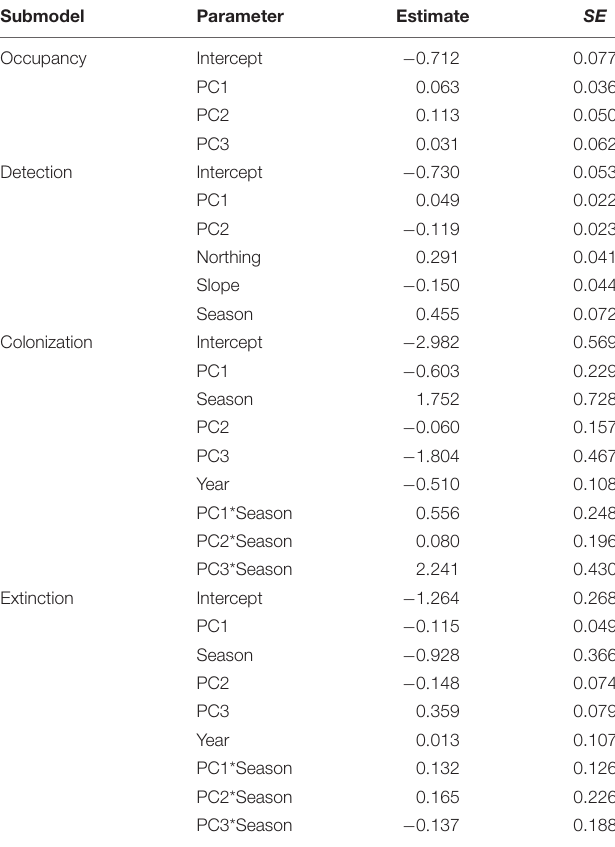
TABLE 5 | Regression coefficient values from the top-ranking dynamic occupancy model (fm23) explaining initial occupancy, detection, colonization, and extinction probabilities in relation to habitat variables (principal components), terrain, season, or year for moose ( Alces alces , n = 74) in northeastern Vermont, United States.